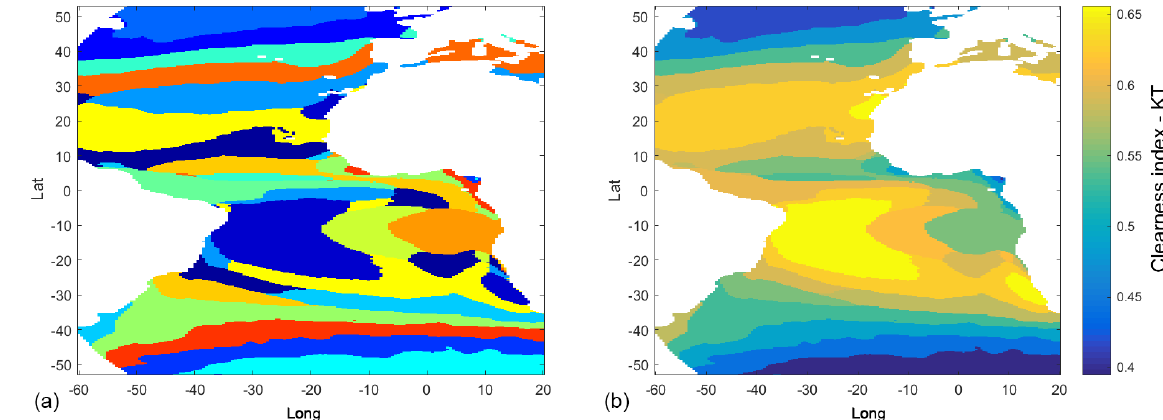
Figure 5. Map of the 17 classes of clearness index KT (a) . Map of the same classes but whose colour indicates the yearly mean of KT (b)